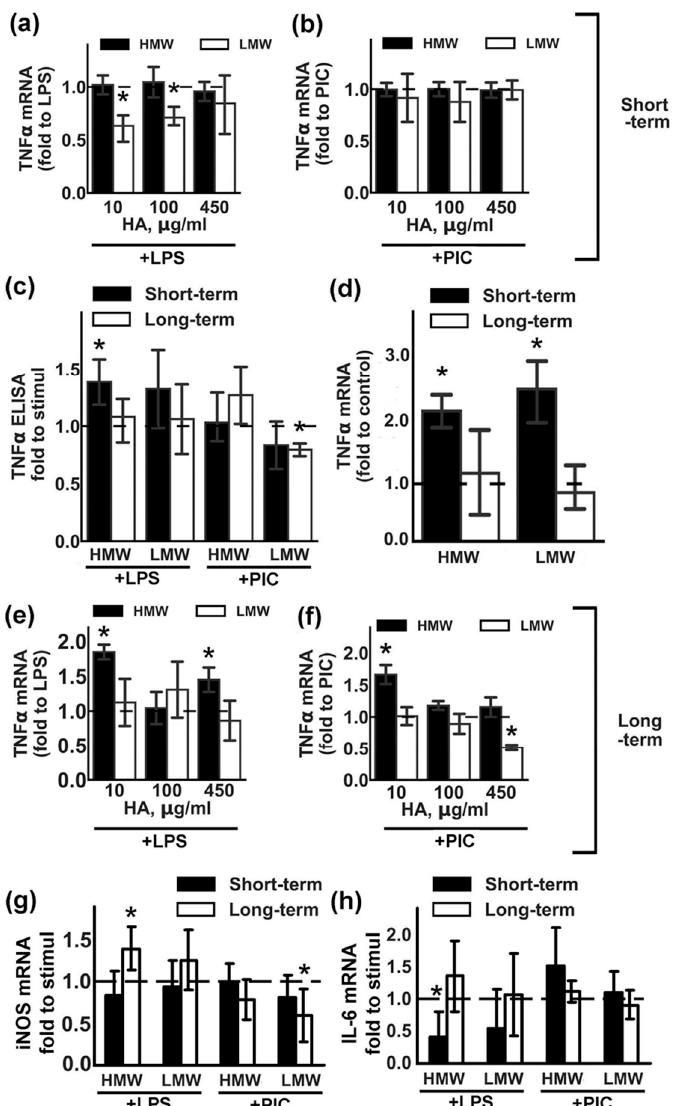
Figure 1. E ff ects of low molecular weight (LMW) and high molecular weight (HMW) hyaluronic acid (HA) on the expression of TNF α upon stimulation with TLR3 and TLR4 agonists. Astrocytes were pretreated for 0.5 h (short-term) or 48 h (long-term) with LMW (10, 100, 450 µ g / mL) and HMW (10, 100, 450 µ g / mL), then lipopolysaccharide (LPS) (100 ng / mL) or Poly:IC (PIC) (10 µ g / mL) were added for 4 h. Relative TNF α mRNA levels were determined by real-time PCR, the data were normalized to the β -actin mRNA levels. Results in ( a , b , e , f ) are presented as fold-changes of TNF α relative to the LPS or PIC-stimulated cells without HA treatments. Results in ( d ) are presented as fold-changes of TNF α relative to the non-treated cells. ( c ) TNF α concentrations were measured by ELISA in supernatant from samples with long- (white bars) and short (black bars) -term HMW (450 µ g / mL) and LMW (450 µ g / mL) HA pretreatment followed by LPS and PIC stimulation for 4 h. Results in ( c ) are presented as fold-changes of TNF α relative to the LPS or PIC-stimulated cells. Results in ( g , h ) are presented as fold-changes of iNOS and IL-6 mRNA levels relative to the LPS or PIC-stimulated cells. Values represent mean ± SEM from three independent experiments performed in triplicate. * p < 0.05, compared with the stimulated cells ( a , b , c , e , f ), * p < 0.05, compared with the unstimulated cells in ( d ).